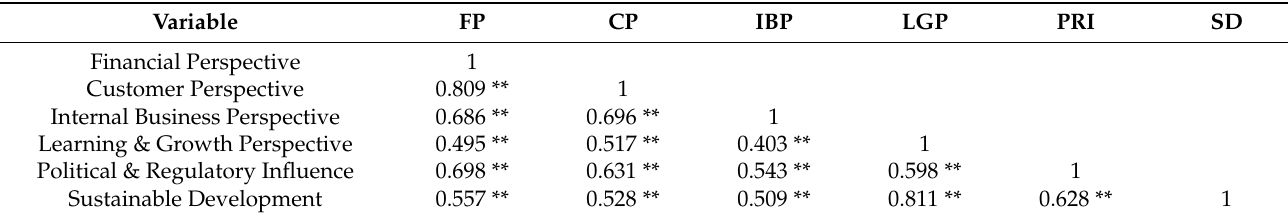
Table 5. Correlation